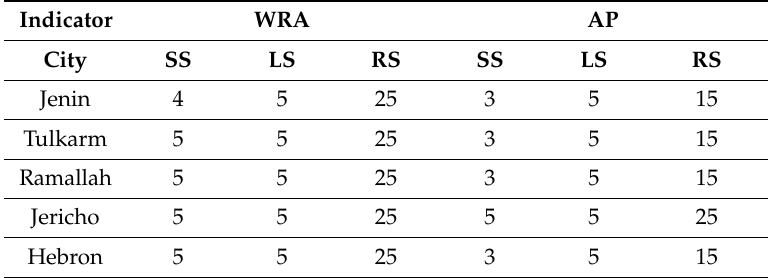
Table 7. Risk score (RS) for the water resources availability (WRA) and the annual precipitation (AP). Indicator